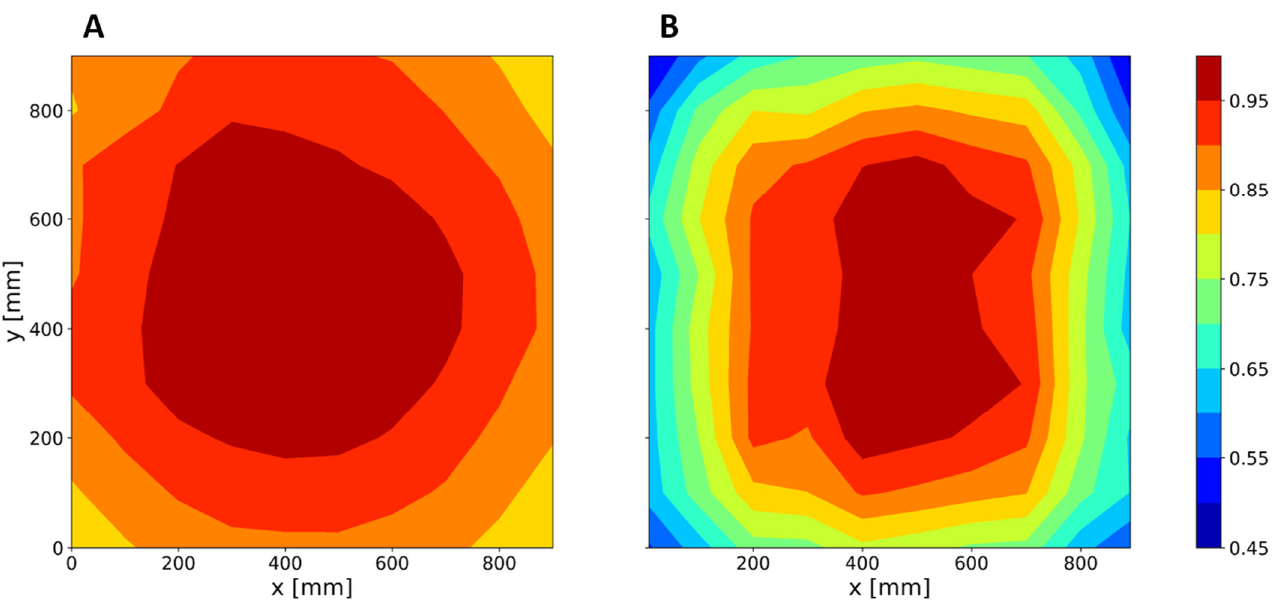
Figure 3. Relative photosynthetic photon irradiance (PPFD) distributions ( EPAR ( x , y )/ Emax,PAR ) measured for illuminance settings (A),(B). The mounting height of the luminaire was 1612 mm in ( A ), therefore only the flat middle portion of the emitted light determined the spatial distribution. Signifi- cantly lower PPFD values were measured at the boundaries of the target area in ( B ). The difference can be attributed to the low (200 mm) mounting height in setting (B) compared to setting